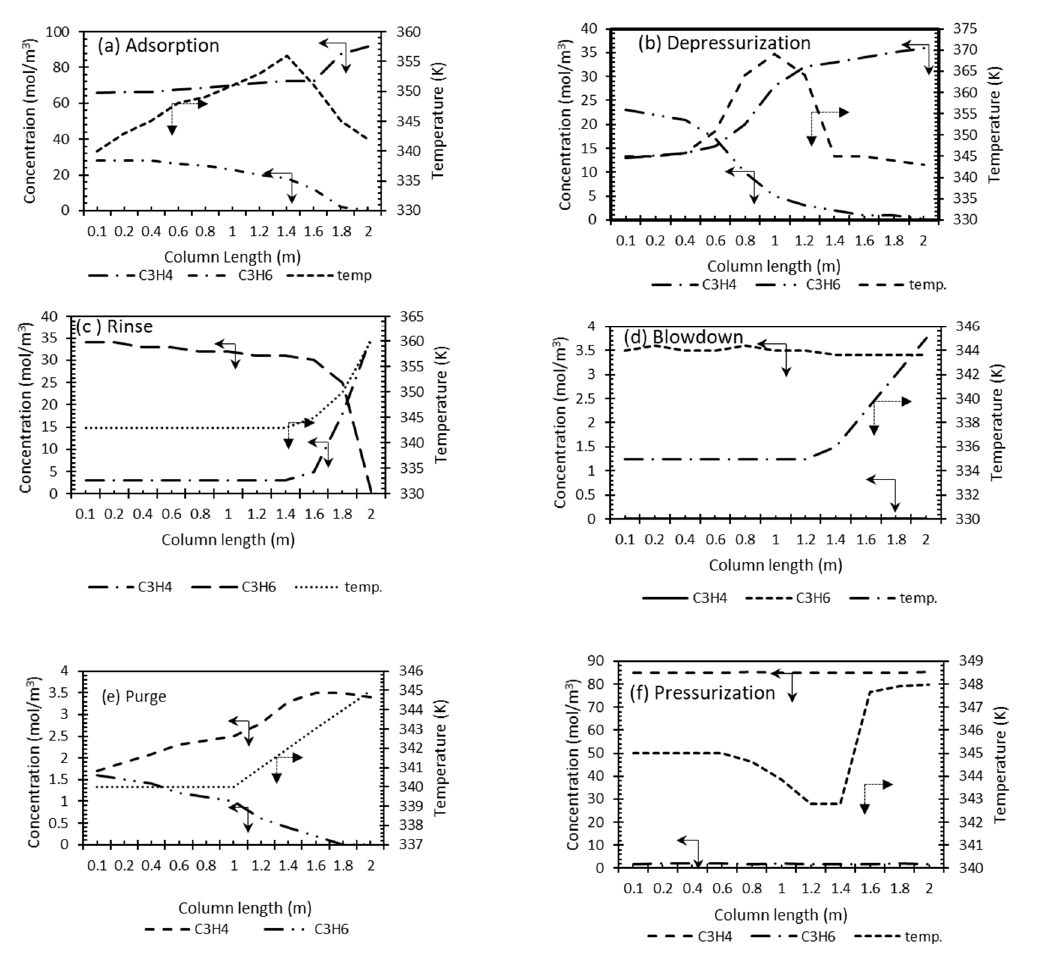
Figure 8. Concentration and temperature history for various stages in VSA column: ( a ) adsorption (800 s, 250 kPa, 1.2 SLPM) ( b ) Depressurization (100 s, 100 kPa); ( c ) rinse (600 s, 100 kPa, 1.2SLPM); ( d ) blowdown (100 s, 250–10 kPa); ( e ) purge (600 s,